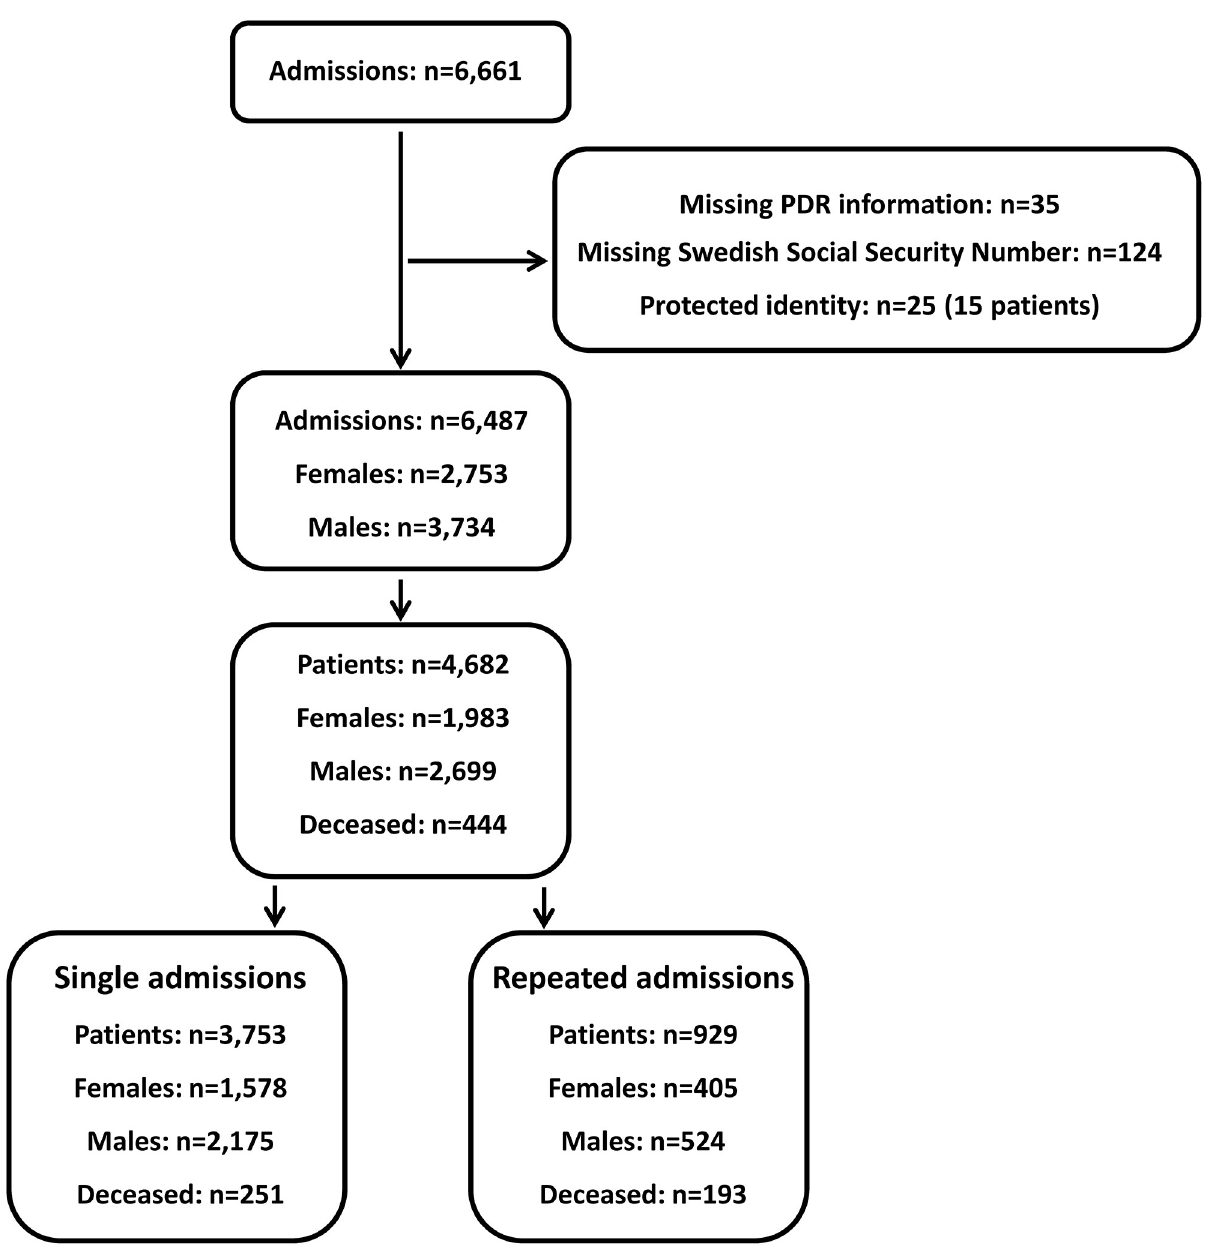
Fig 1. Consort diagram. The cohort of patients included in the study, derived from all admissions to the PICU, and presented as single and repeated admissions.